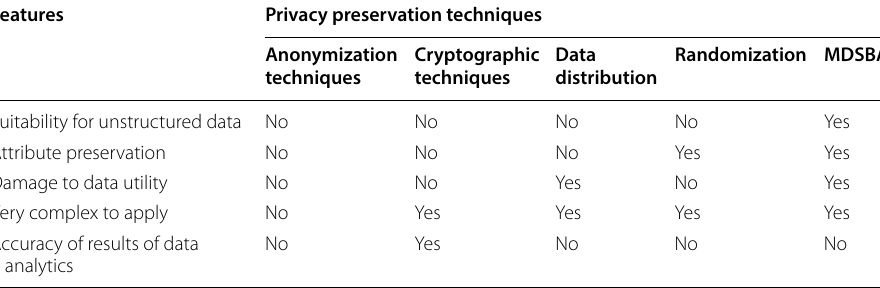
Table 5 Comparison of privacy preservation techniques